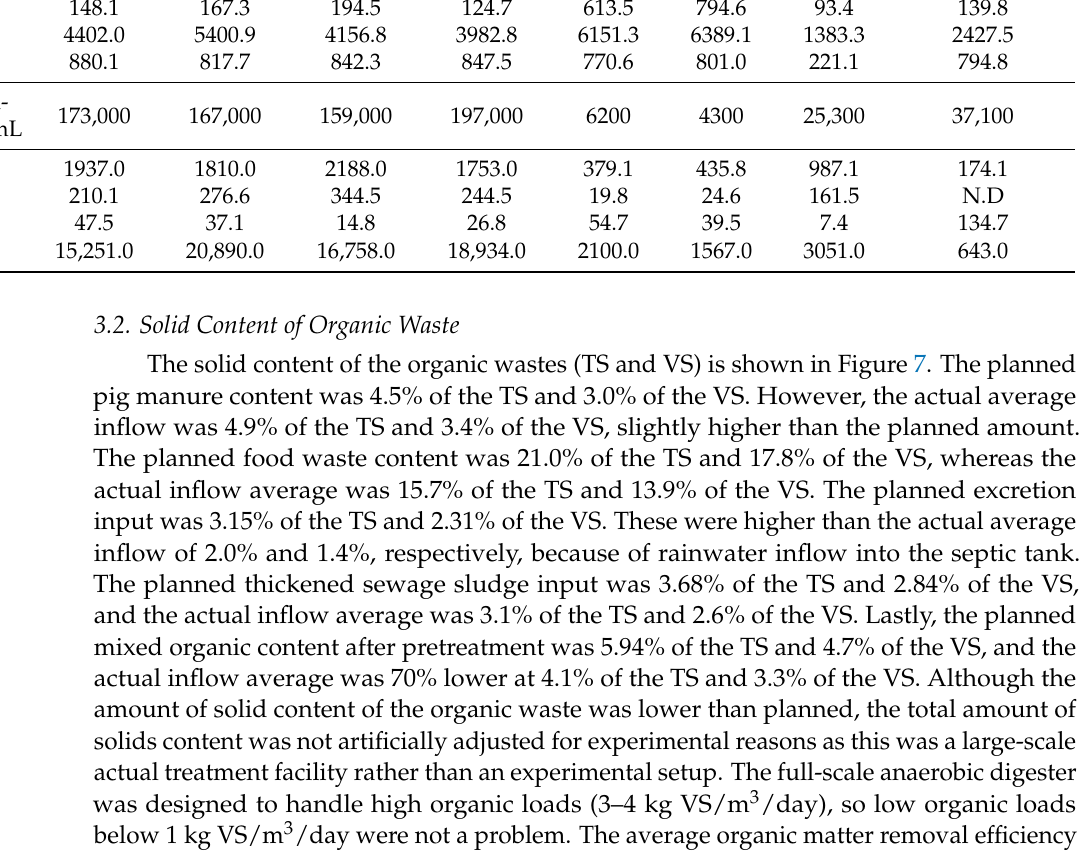
Figure 7. Change in the TS and VS content of ( a ) pig manure, ( b ) food waste, ( c ) excretion, ( d ) thick ‐ ened sewage sludge, and ( e ) mixed waste.